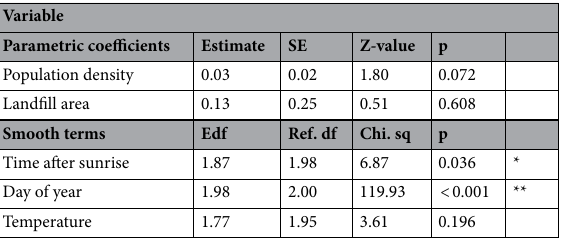
Table 3. The GAMMs’ with the negative binomial distribution describing the relationship between number of white storks observed on the landfill per hour and population size, landfill area, time after sunrise, day of year and temperature. *p < 0.05. **p <